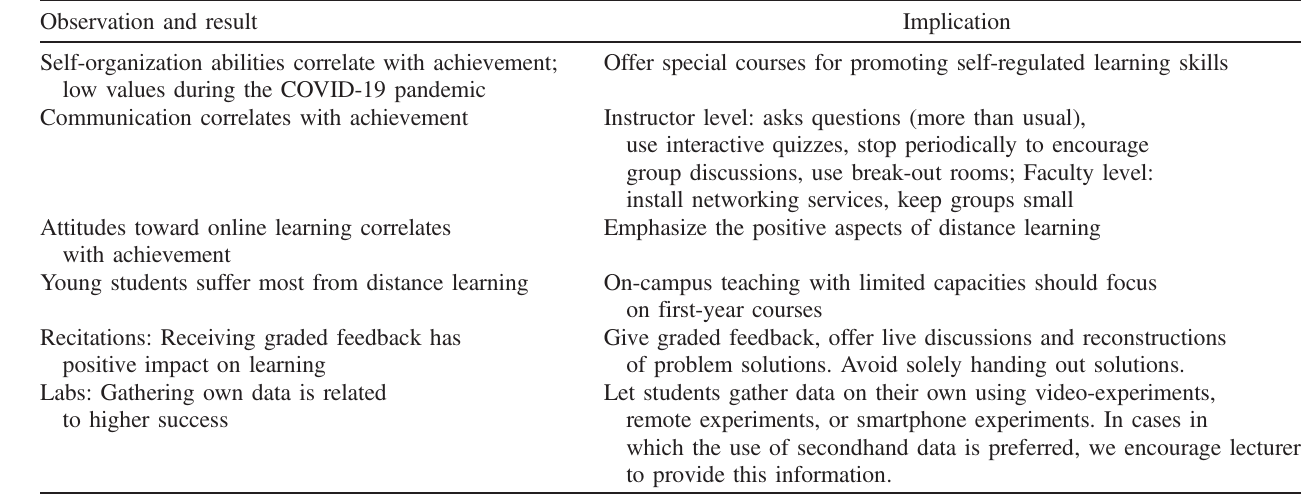
TABLE IV. Observations from the study and suggestions for practical implications. For more details, please refer to the textual discussion. Achievement and success refer to students ’